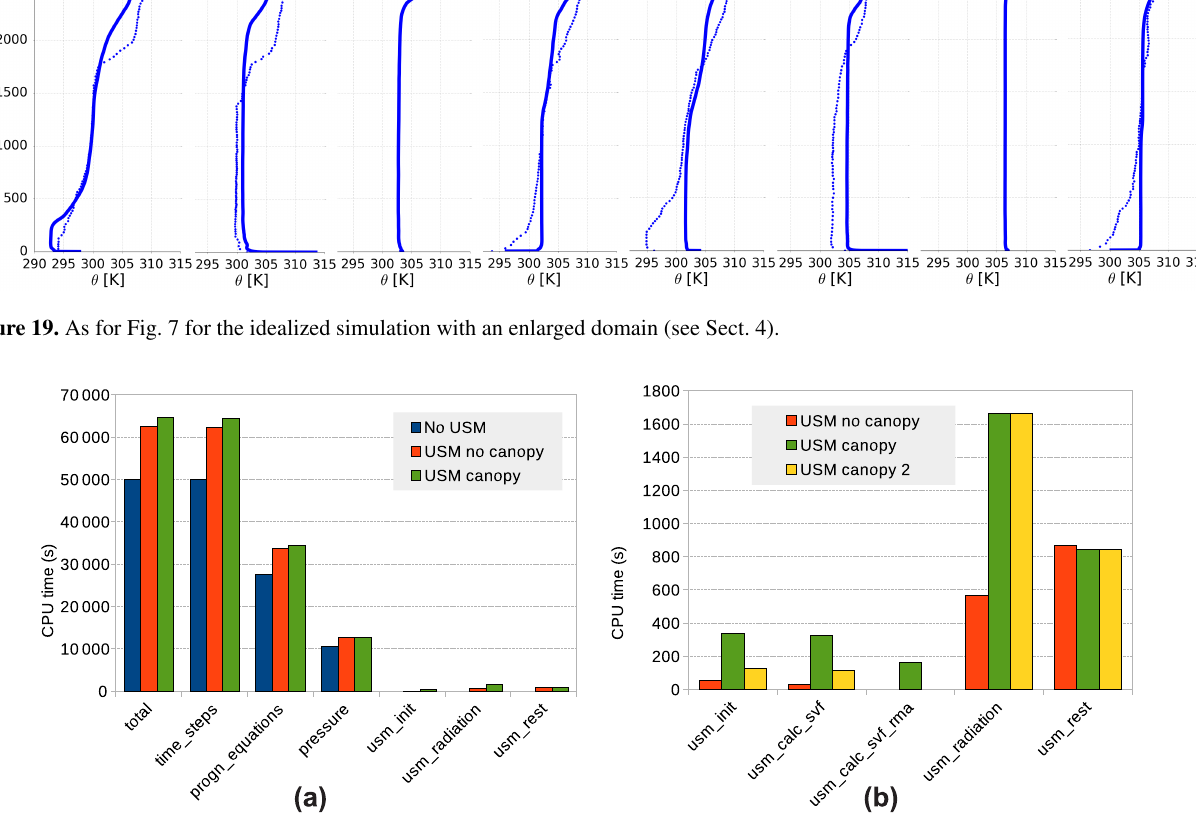
Figure 20. Comparison of the duration of the model run and the time spent in the chosen subprocesses of the model (a) and detailed comparison of parts of the USM model (b) . Meaning of data series: “no USM” the run of PALM with USM switched off, “USM no canopy” the run with USM with no plant canopy, “USM canopy” run with USM and plant canopy, and “USM canopy 2” the same run with the model configuration option usm_lad_rma turned off. Meaning of items: total – total CPU time of the model run; time_steps – time spent in time stepping; progn_equations – evaluation of all prognostic equations; pressure – pressure calculation; usm_init – initialization routines of